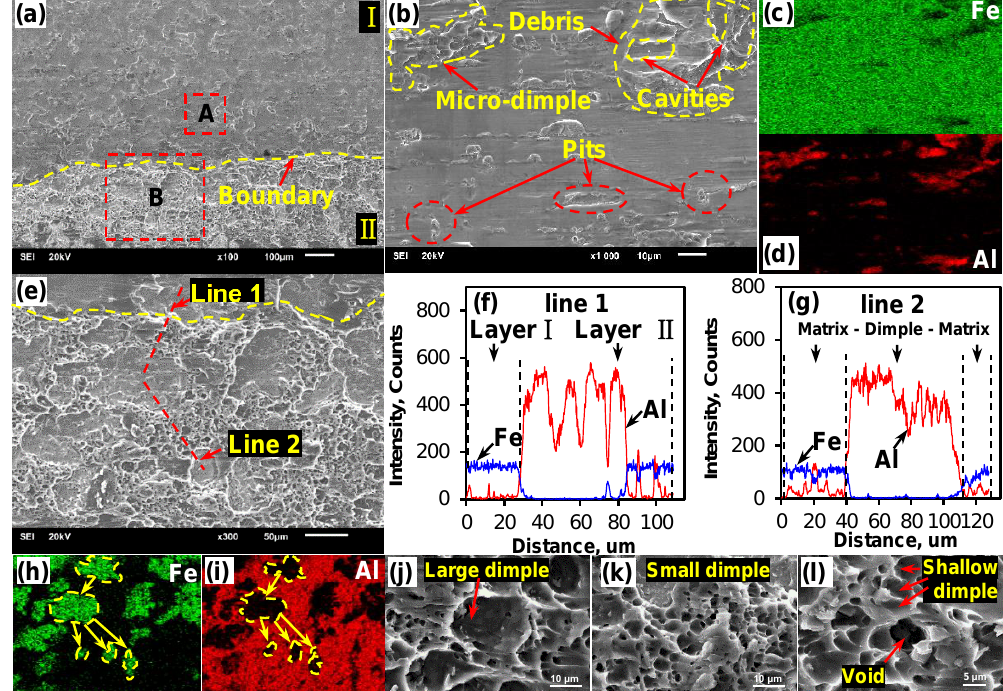
Figure 3. The evolution of morphology and characteristics in ( a – d ) layer I and ( e – l ) layer II: ( a ) a low magnification image showing layer I, layer II, and their boundary; ( b ) a magnified image of area ‘A’ in ( a ), showing the impact features in layer I (near the boundary); ( c , d ) EDS elemental maps of ( b ); ( e ) a magnified image of area ‘B’ in ( a ); ( f , g ) EDS line scan results along lines 1 and 2 in ( e ); ( h , i ) EDS elemental maps of ( e ); ( j – l ) typical dimple fracture features in ( e